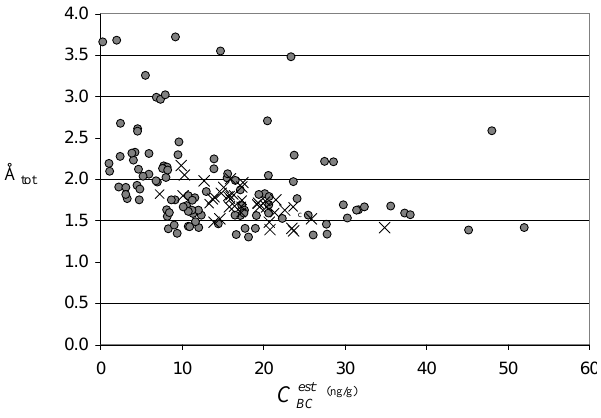
Fig. 15. ˚A tot vs. C est at Ny- ˚Alesund (gray circles) and Tromsø BC (69 ◦ N, 19 ◦ E; crosses) in 2008 before the onset of melt.